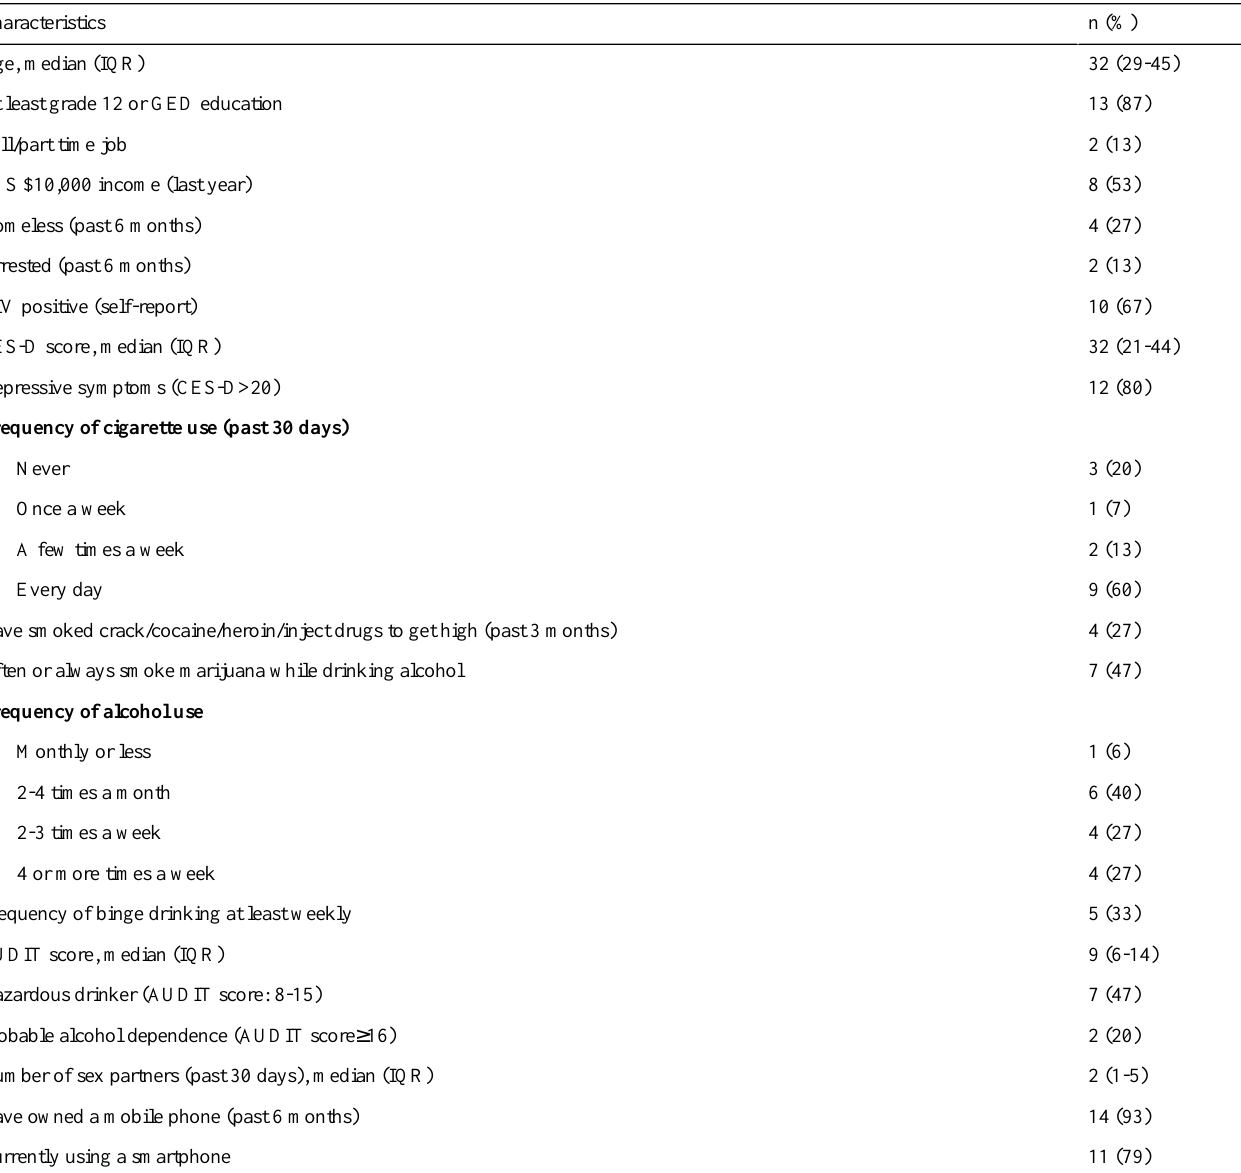
Table 2. Baseline characteristics of participants